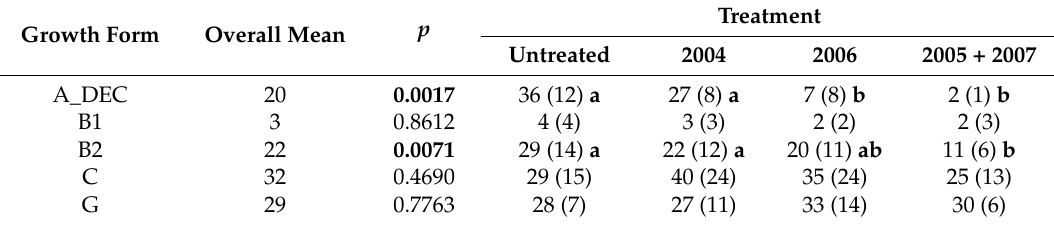
Table 6. Effects of treatments on the cover of each of the major growth forms for each year of measurement. Standard deviation is shown in brackets () beside each mean. Where Analysis of Variance indicates significant treatment effects ( p < 0.10), p values are shown in bold and bold letters are used to indicate differences between treatments determined using Tukey’s HSD test ( p < 0.10). Growth forms: A_Dec = deciduous tree layer; B1 = tall shrubs; B2 = low shrubs; C = Herbs and Forbs; G = grasses, sedges, and